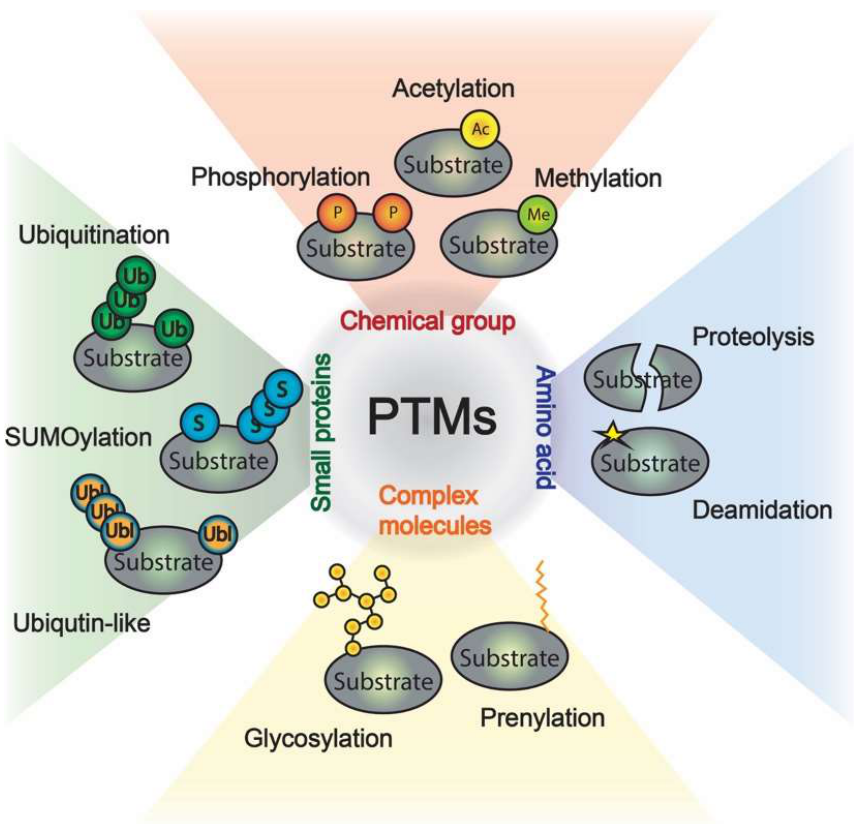
Figure 1. Post-translational modifications of proteins. Chemical group modifications are shown in red, amino acid modifications in blue, complex molecules are in yellow, and additions of small proteins are displayed in green.